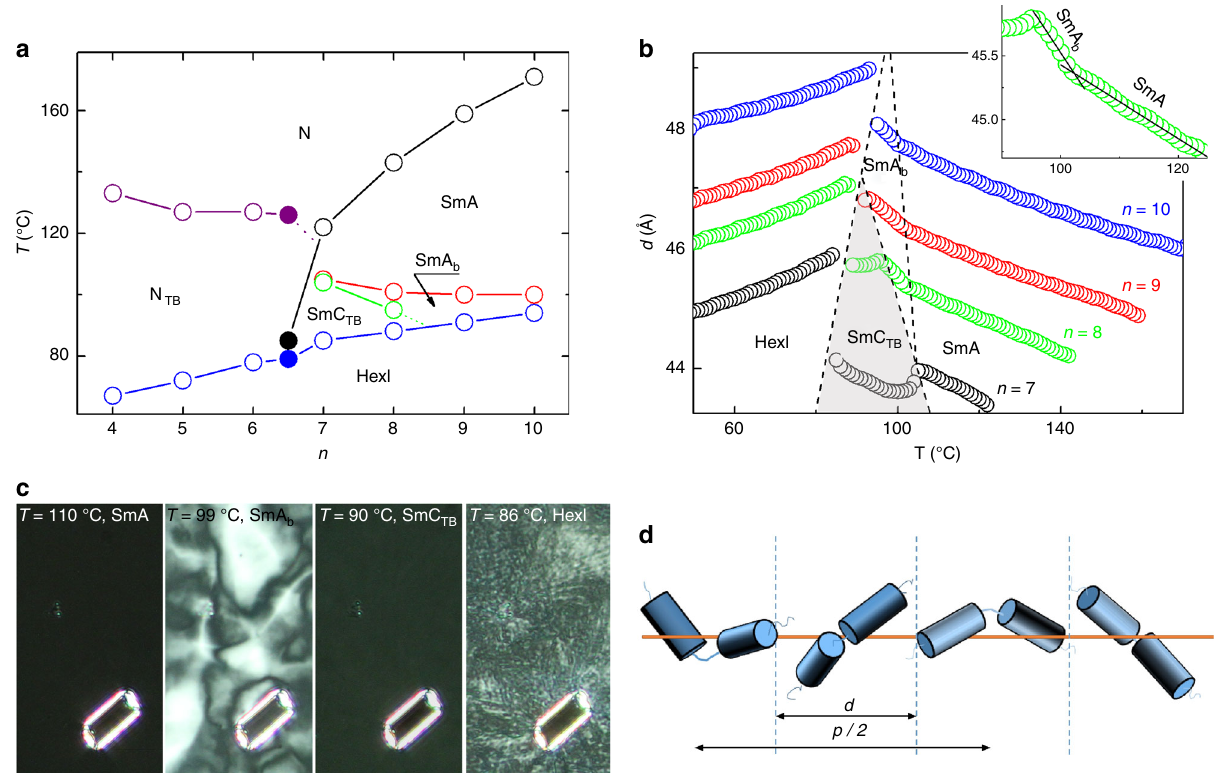
Fig. 2 Phase behaviour. a Phase diagram for the achiral CB6OIBeOn series with n = 4 – 10, the fi lled points correspond to a 50 – 50 wt.% mixture of homologues n = 6 and 7. b Smectic layer spacing, d , vs. temperature for CB6OIBeOn compounds with n = 7 – 10. The dependence, d ( T ), for n = 7 and 8 suggests a transition from an orthogonal to a tilted phase. The highlighted area is the heliconical smectic C TB phase. In the inset is the enlarged fragment of d vs. T for homologue n = 8, which clearly shows the SmA-SmA b phase transition. c Optical textures of the uniaxial SmA, biaxial SmA b , helical SmC TB and HexI phases, observed in an homeotropic cell, between crossed polarizers, for homologue CB6OIBeO8. A glass bead is visible in the picture to mark the same area of the presented textures. Note that the SmC TB phase is uniaxial, which excludes a simple synclinic or anticlinic tilted structure. d Schematic drawing of the proposed model for SmC TB phase structure in which dimeric molecules form a short-pitch helix, p stands for pitch length. The dotted vertical lines denote smectic layer interfaces, spaced by